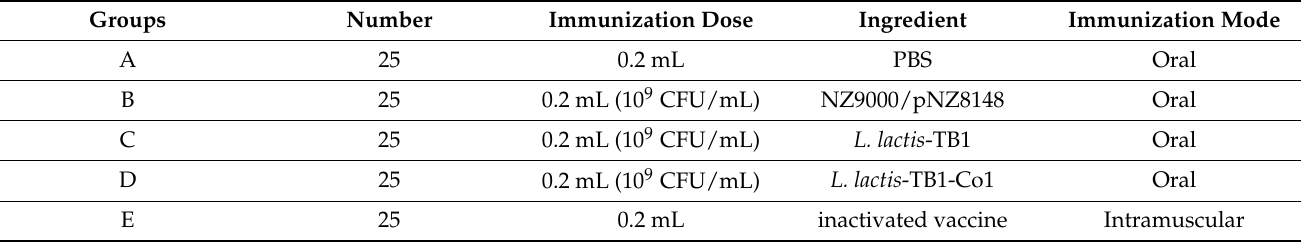
Table 4. Immunization schedule in mice